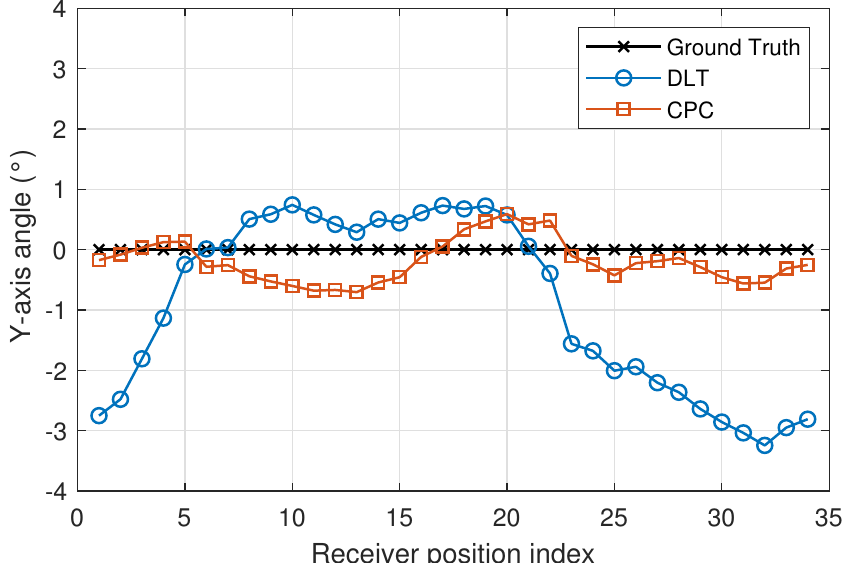
Figure 14. Y-axis angle using DLT and CPC.